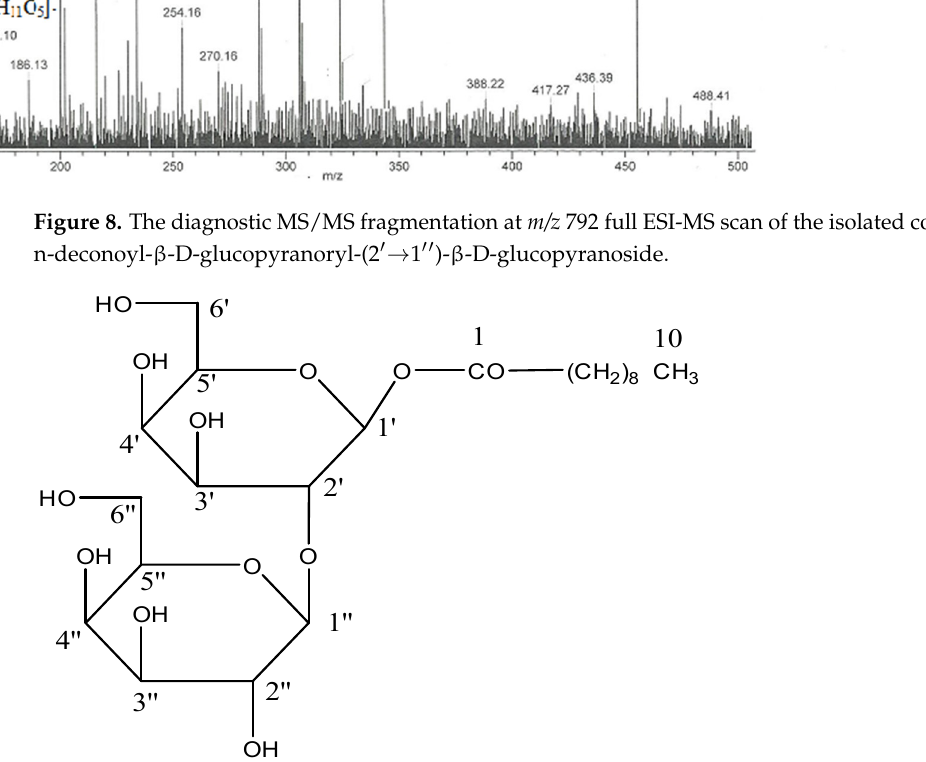
Scheme. 3. Isolated compound n-deconoyl- β -D-glucopyranoryl-(2 ′→ 1 ′′ )- β -D-glucopyranoside Scheme 3. Isolated compound n-deconoyl- β -D-glucopyranoryl-(2 (cid:48) → 1 (cid:48)(cid:48) )- β -D-glucopyranoside (AB 03). (AB